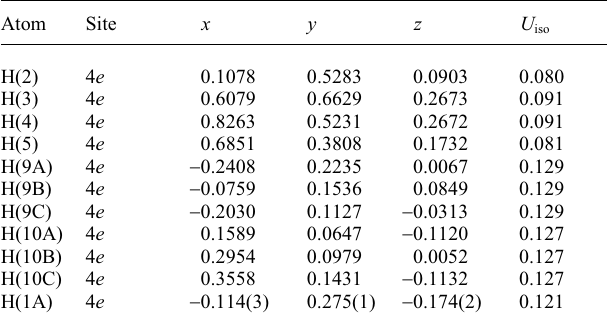
Table 2. Atomic coordinates and displacement parameters (in Å 2 )